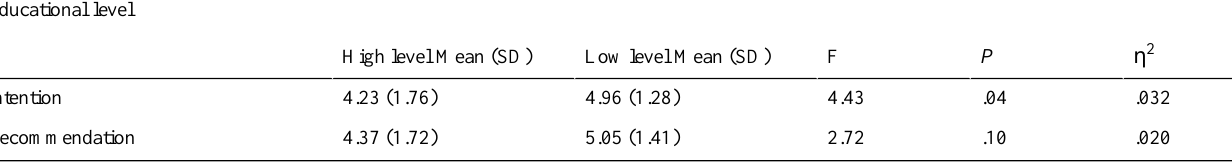
Table 6. Differences in variances of socioeconomic status with regard to future adherence